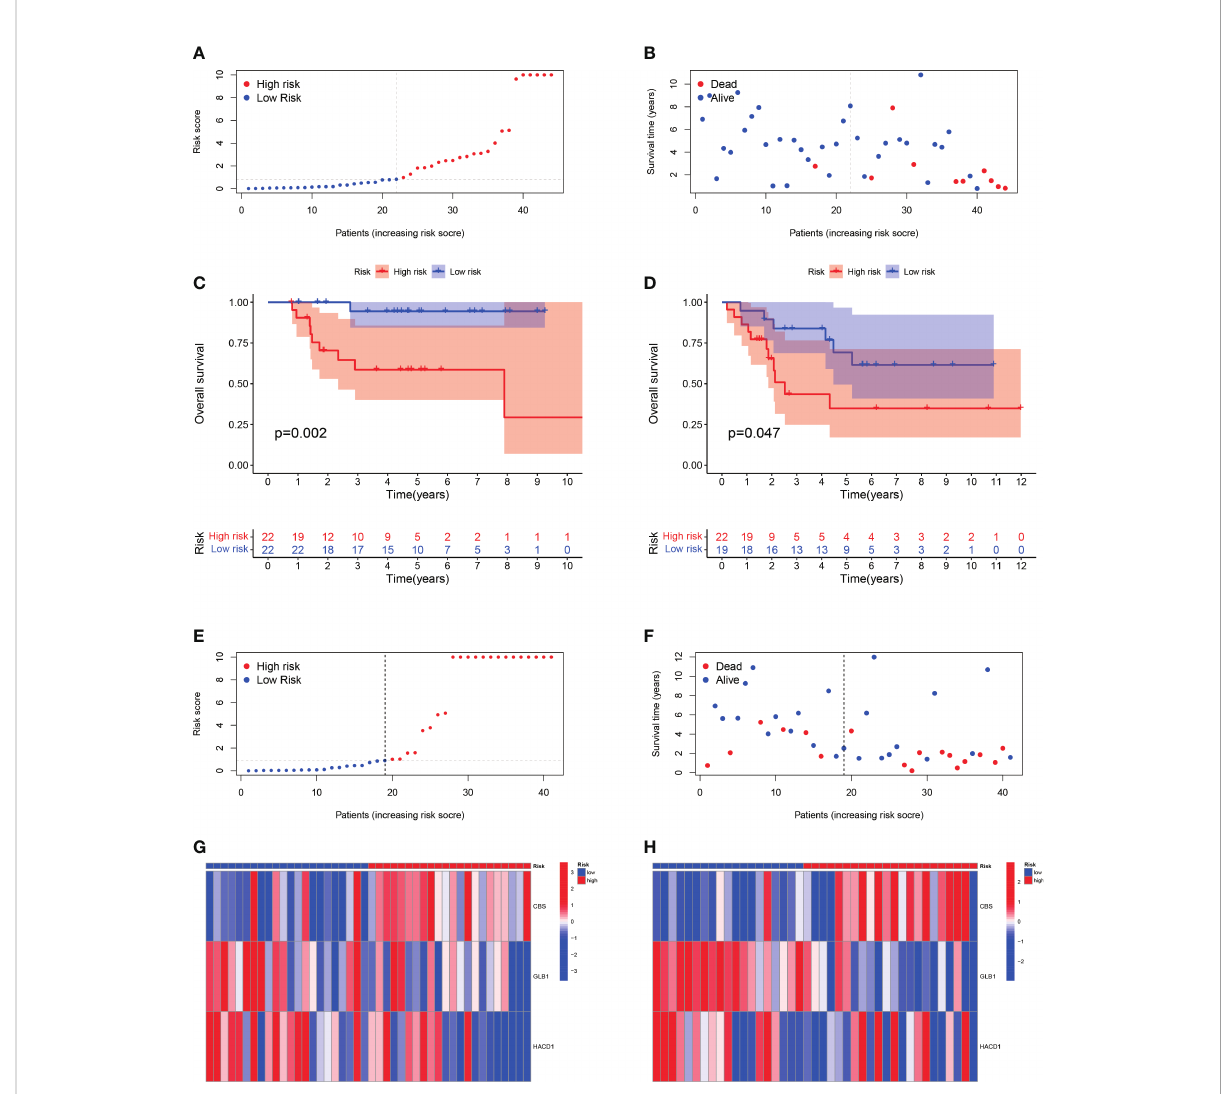
FIGURE 3 The estimation ef fi cacy of the SM-relevant risk model in predicting the overall survival of OS patients. (A, B) Risk scores and distribution of OS patients in train cohort. (C, D) Comparison of the overall survival in the train and validation cohort between the two groups. The results show a signi fi cant different overall survival in high-OS and low-OS groups. (E, F) Risk scores and distribution of OS patients in validation cohort. (G, H) Heat map of prognostic model genes in the train and validation